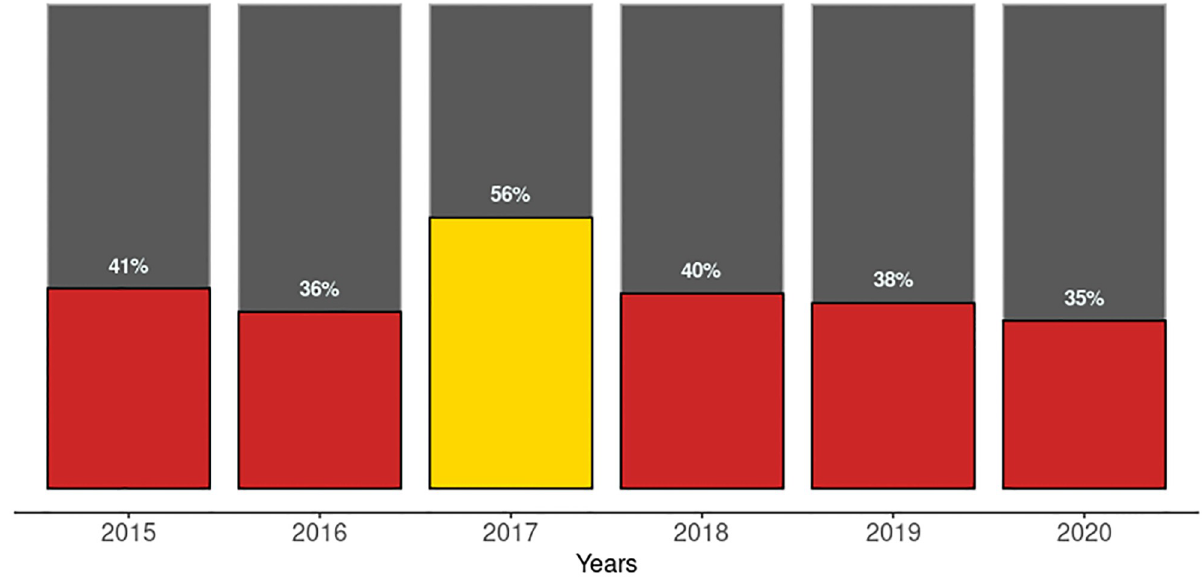
Fig 2. Battery chart showing trends in the number of pregnant women seen at PMTCT reporting facilities as a percentage of estimated pregnant women from 2015–2020.